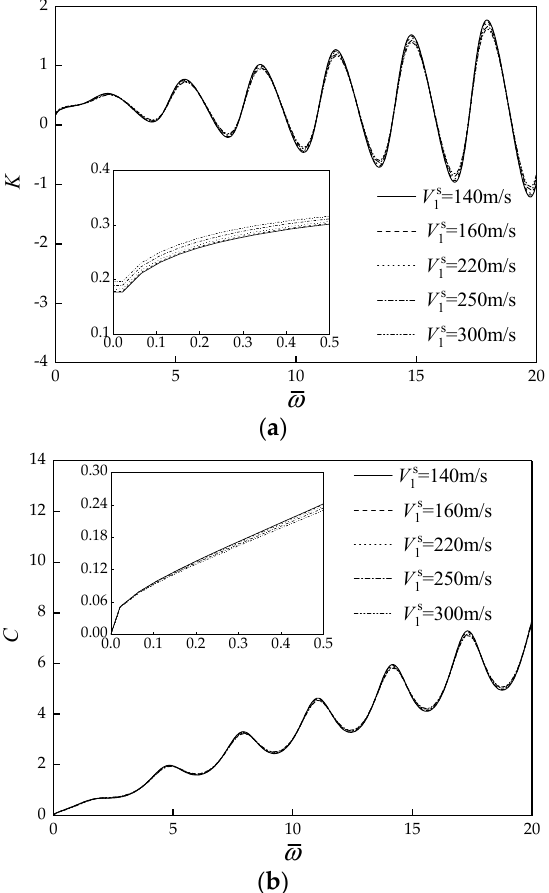
Figure 4. Effect of PES shear wave velocity on the vertical dynamic impedance of pile. ( a ) Dynamic stiffness curves; ( b ) Dynamic damping curves.